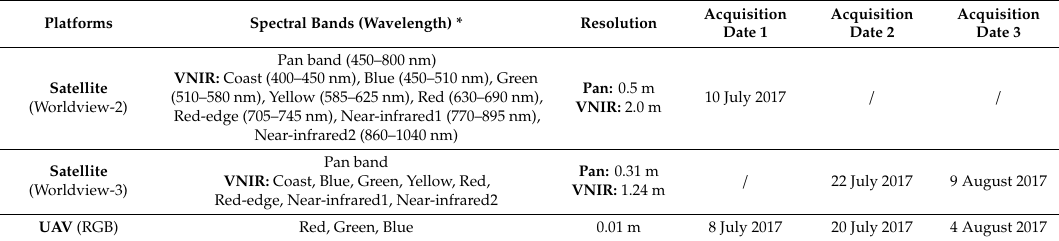
Table 2. Satellite and unmanned aerial vehicle (UAV) remote sensing data and acquisition date.